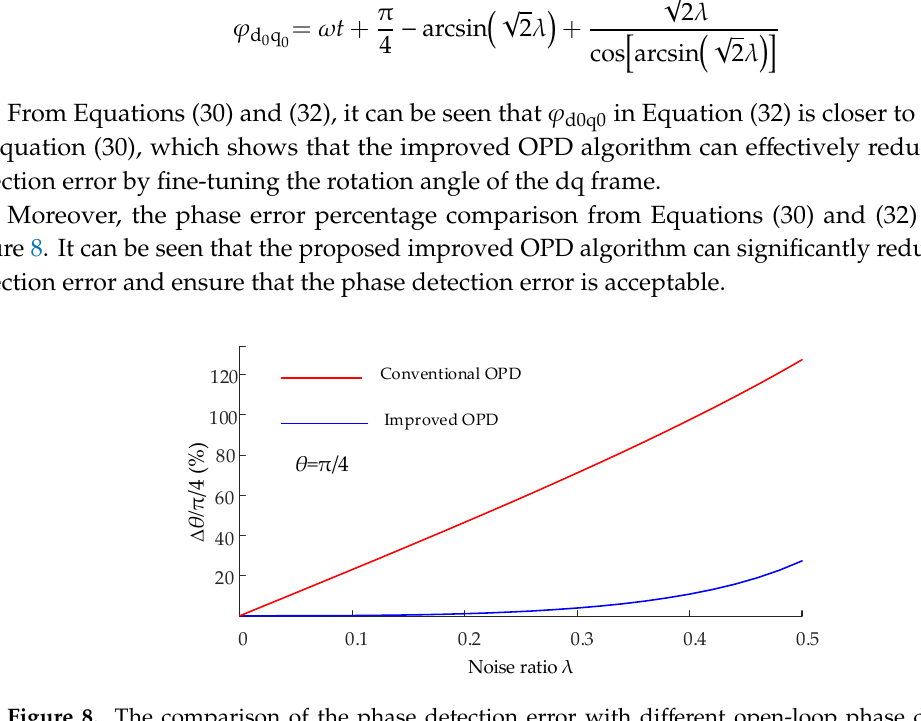
Figure 8. The comparison of the phase detection error with different open-loop phase detection methods (OPDs).